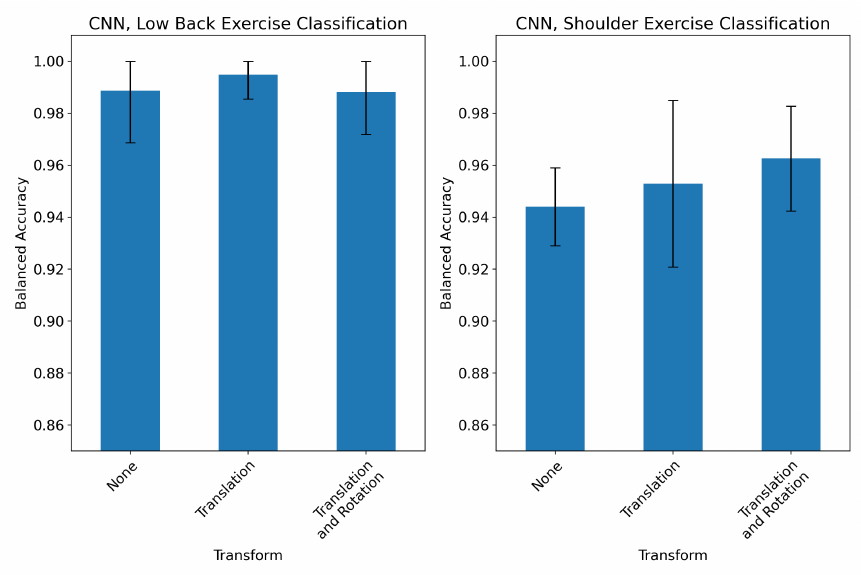
Figure 3. Effect of coordinate transforms on classification model performance for low back ( left ) and shoulder ( right ) exercises, using only videos from one camera angle for each exercise. Plots show the mean ± 95% CI class-balanced accuracy in a 5-fold cross validation experiment, creating folds by participant. The transform (either no transform, translation, or translation and rotation) was applied to both training and validation records in each fold.